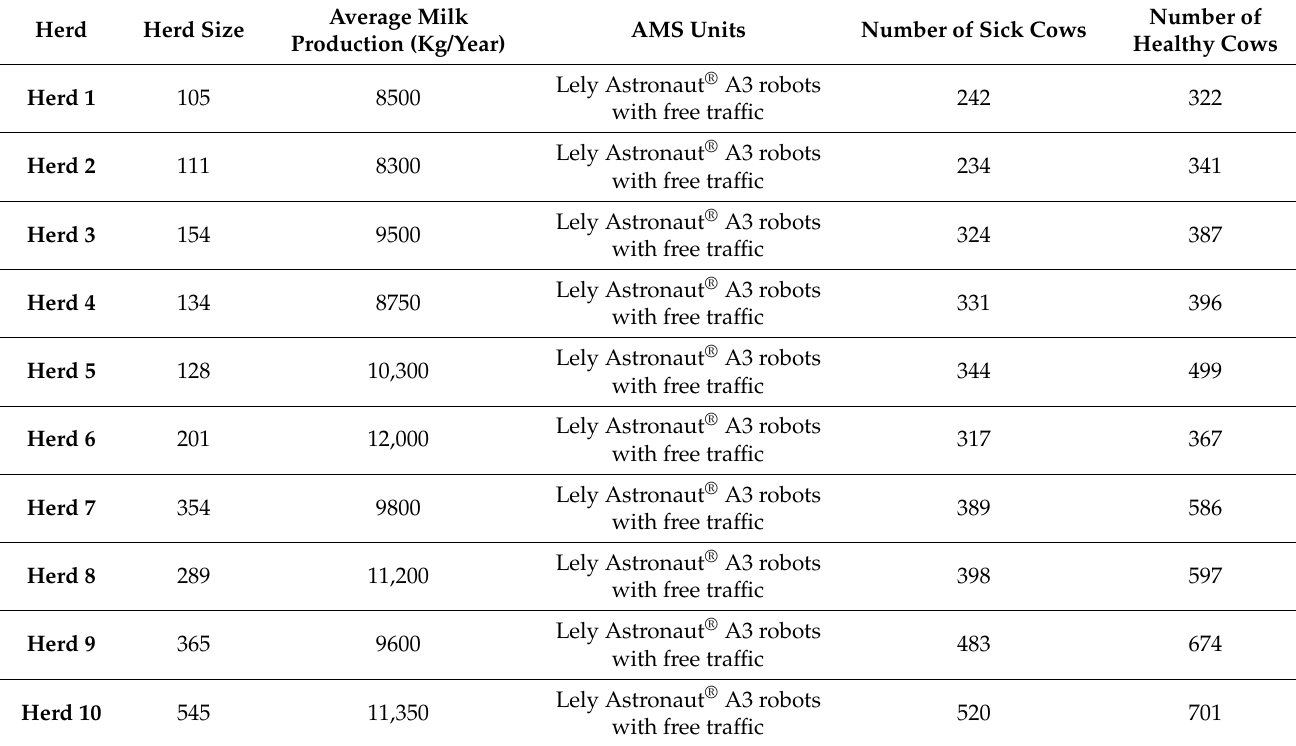
Table 1. Description of herd